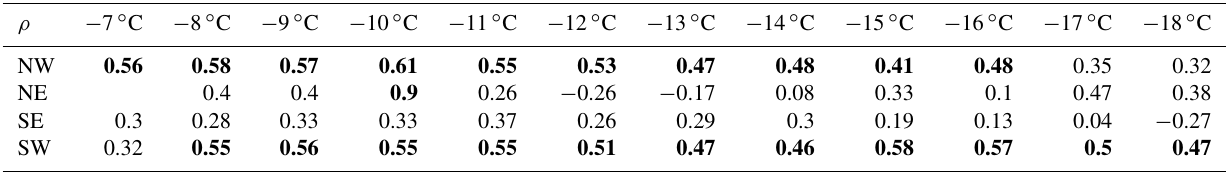
Table A2. Spearman’s rank coefficients ( ρ ) between the Froude number and INP concentrations at different temperatures ( − 7 to − 18 ◦ C) per wind sector (see Fig. 1). Numbers in bold represent a significant result (two-sided p < 0 . 05). At − 7 ◦ C, only two INP concentrations were available at NE, such that no Spearman’s rank coefficient could be